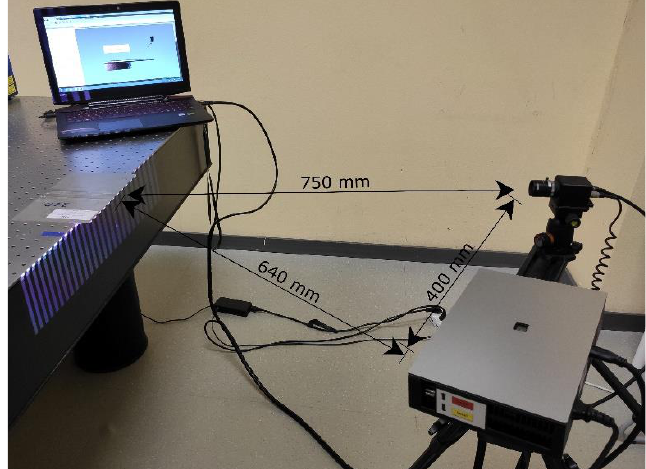
Figure 3. Surface contour measurement using fringe projection.